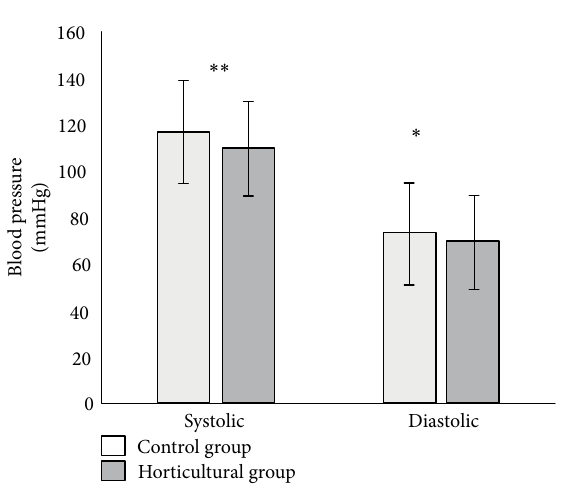
Figure 2: Comparison of blood pressure data between the horticultural group and control group. 푁 = 40 : mean ± SE. ∗∗ 푃 < 0.01 : determined using a paired t -test.